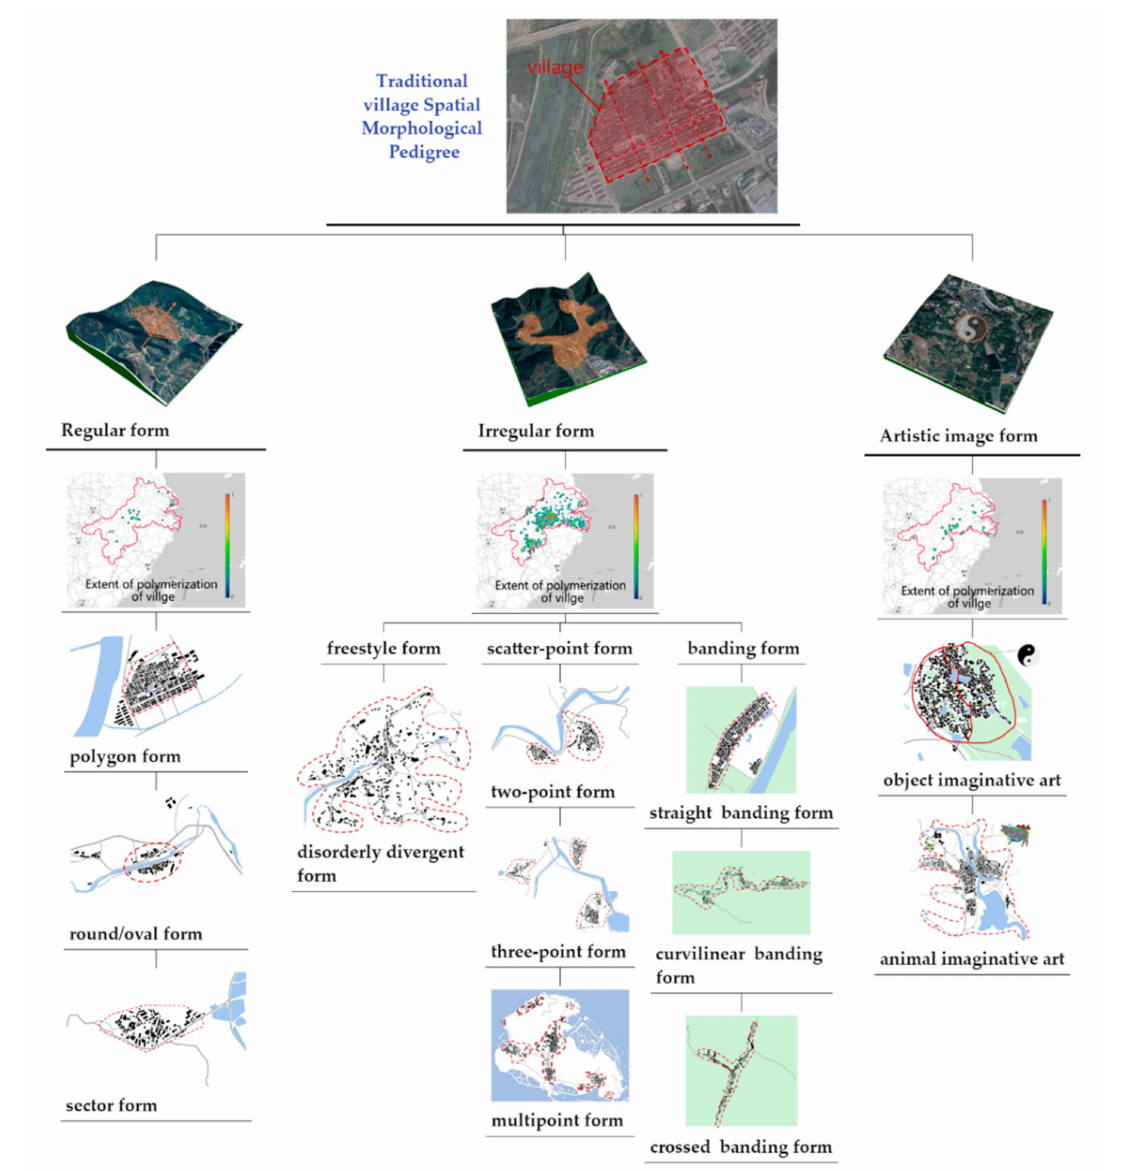
Figure 9. Traditional village spatial morphological pedigree structure: edited by